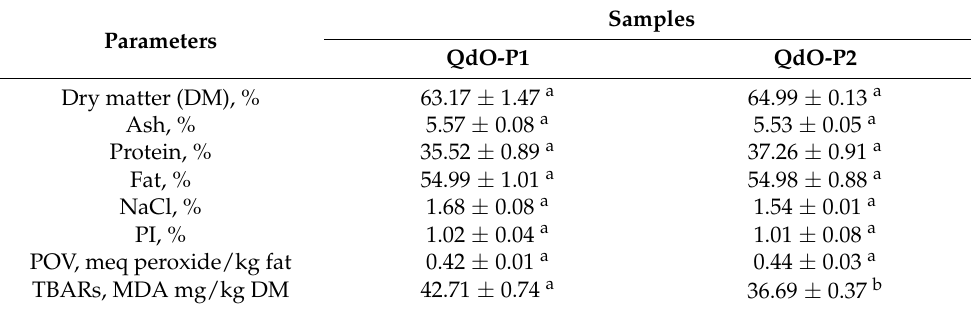
Table 3. Compositional characteristics of Quadrello di ovino